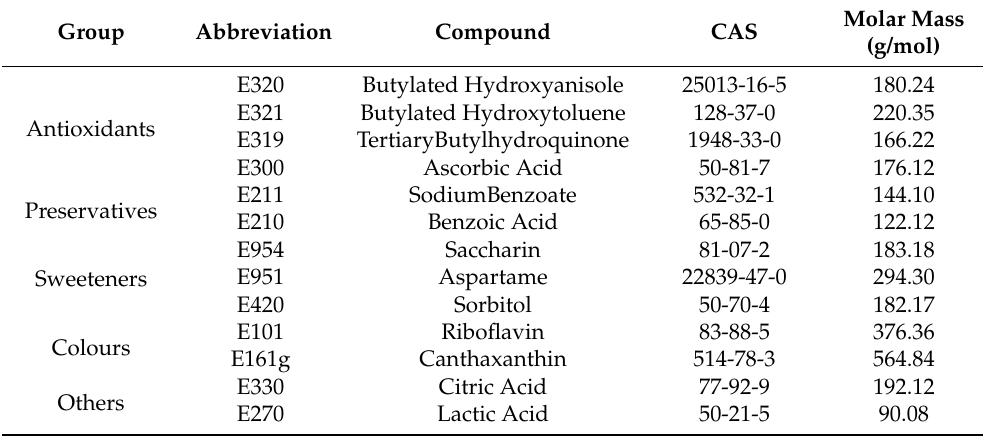
Table 4. List of food additives identified in tested swimming pool water